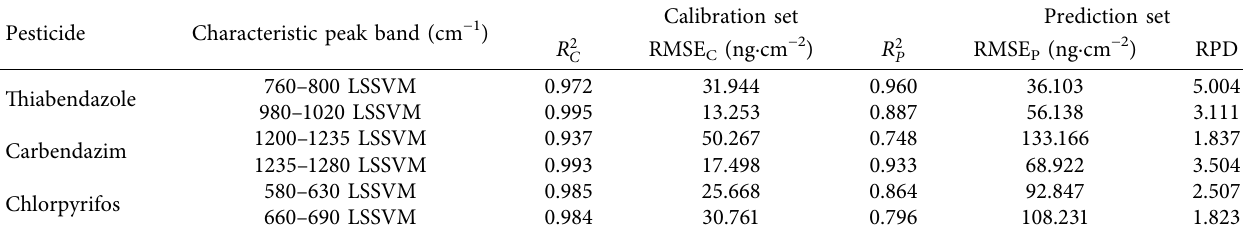
Figure 5: The selected SERS feature spectra of (a) thiabendazole, (b) carbendazim, and (c) chlorpyrifos on tomato under the five con- centrations selected. Table 1: Modeling results based on characteristic